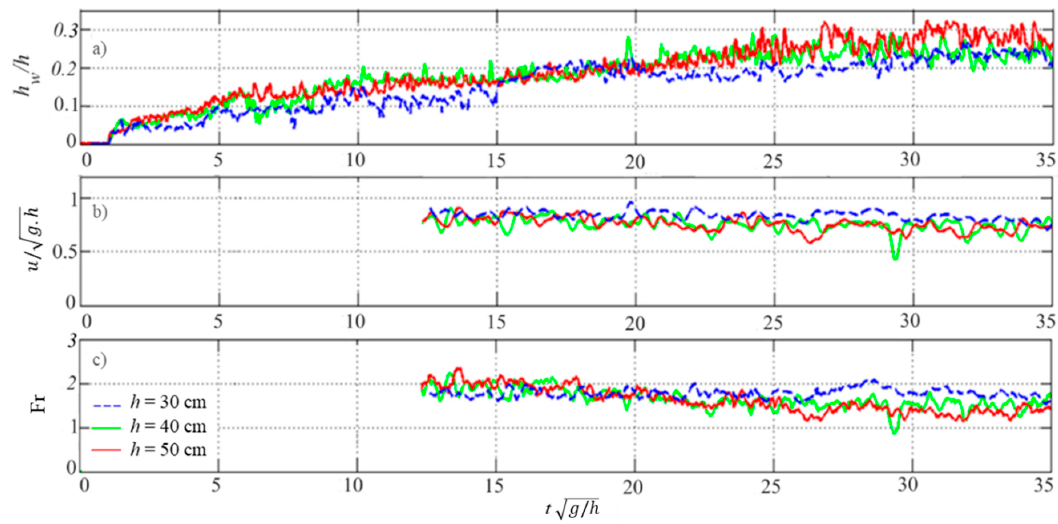
Figure 3. Dry bed surge characteristics at x = 6.5 for h = 30, 40, and 50 cm: ( a ) water surface profile (recorded by wave gauge 3, WG3), ( b ) flow velocity, and ( c ) Froude number.